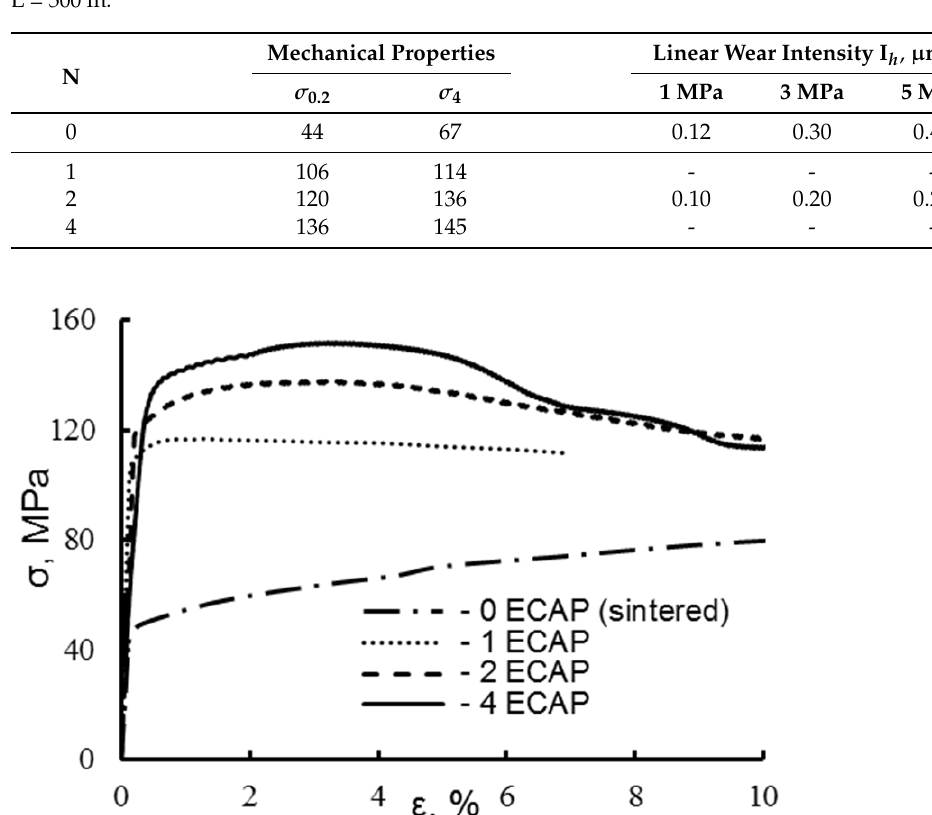
Figure 3. Compression curves of the sintered and subjected to subsequent ECAP with route A Al-30Sn composite.